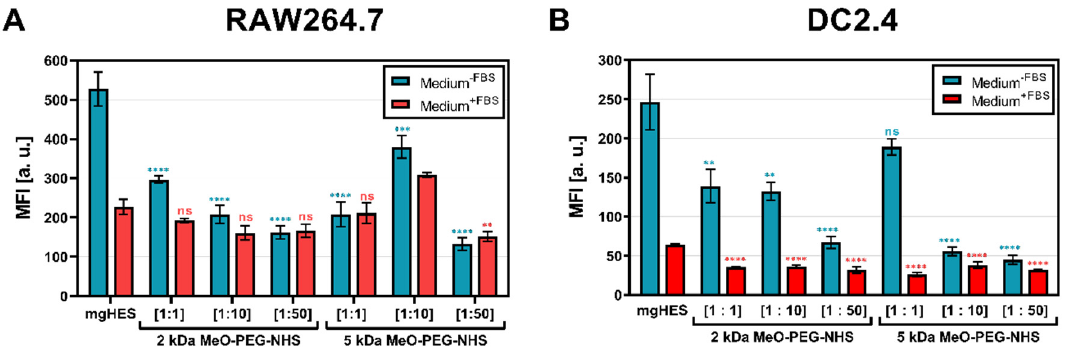
Figure 1. Stealth effect of PEGylated nanocarriers in macrophages and dendritic cells. The cell uptake study in ( A ) RAW264.7 macrophages or ( B ) DC2.4 dendritic cells was conducted using a sample concentration of 7.5 µg mL − 1 and incubation time of 2 h at 37 °C. Autofluorescence is sub- tracted from each data set. Only viable cells are gated. Values are given as mean ± SD ( n = 3). Each